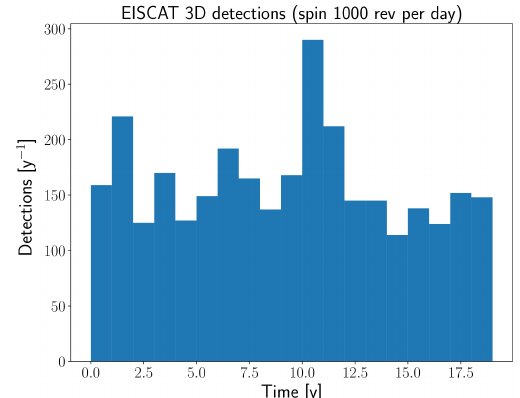
Figure 9. Yearly count of possible observation windows of mini- moons, assuming a rotation rate of 1000 revolutions per day and that a prior orbit is